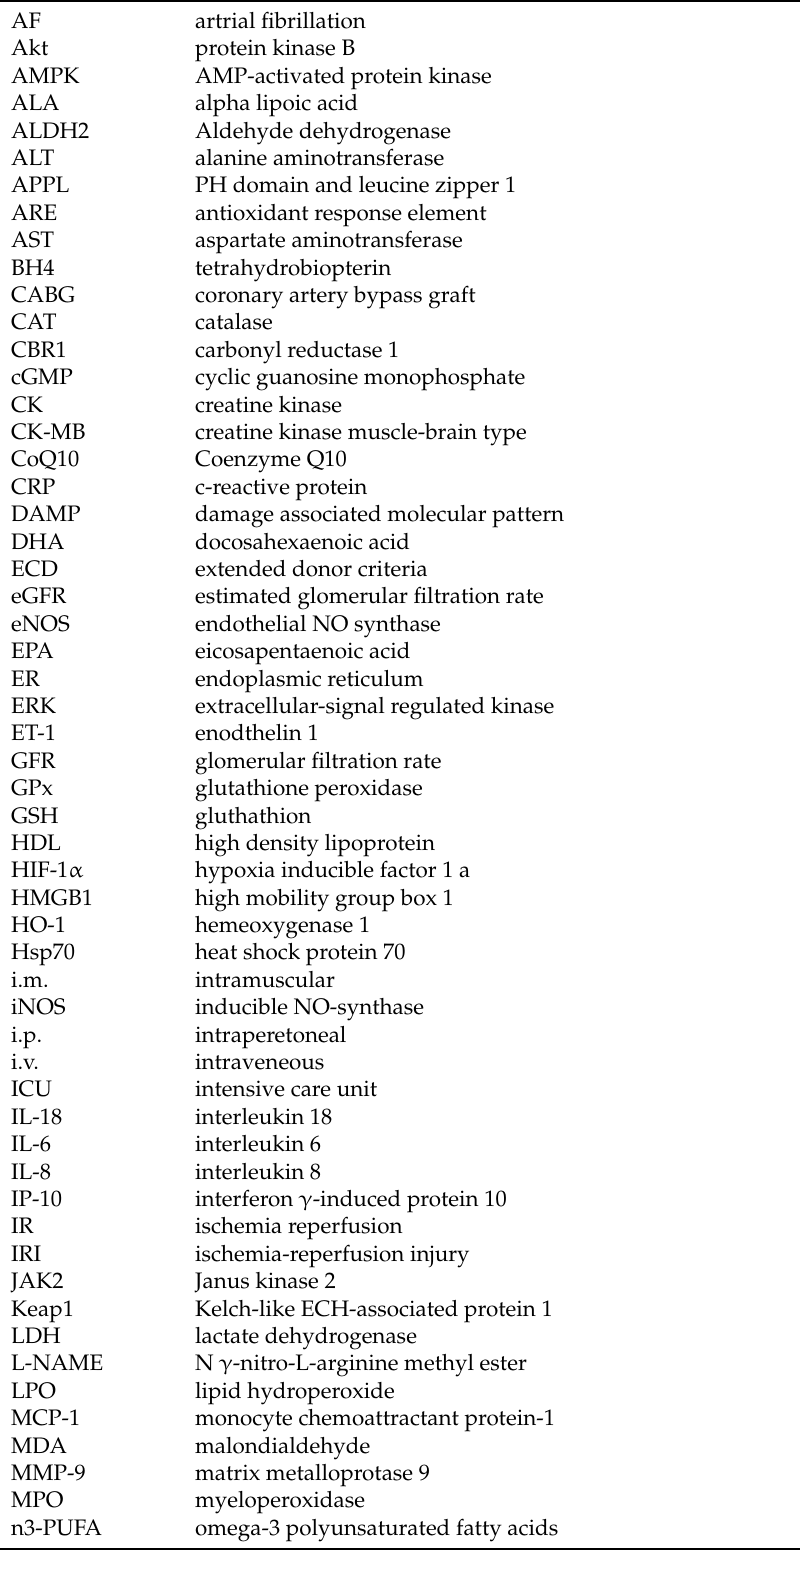
Table 3. List of